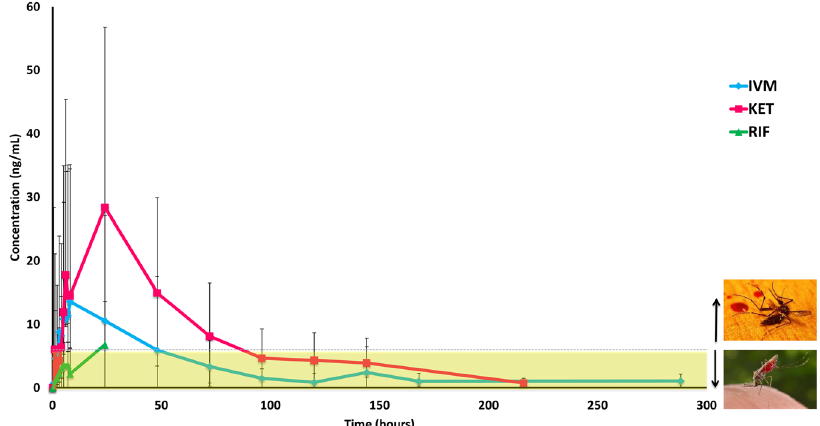
Figure 2. Comparison of median ( ± range) plasma concentrations across different treatment groups. The dashed line indicates the target 10-day lethal concentration (LC 50 ) for Anopheles gambiae . Alive Anopheles image in public domain from CDC Public Health Image Library, photo credit: James Gathany. Dead mosquito image CC-by-sa PlaneMad/Wikimedia available at https://commons.wikimedia.org/wiki/File:Dead_mosquito. jpg. CDC: Centers for Disease Control and Prevention, IVM: ivermectin, KET: ketoconazole, RIF: rifampicin.